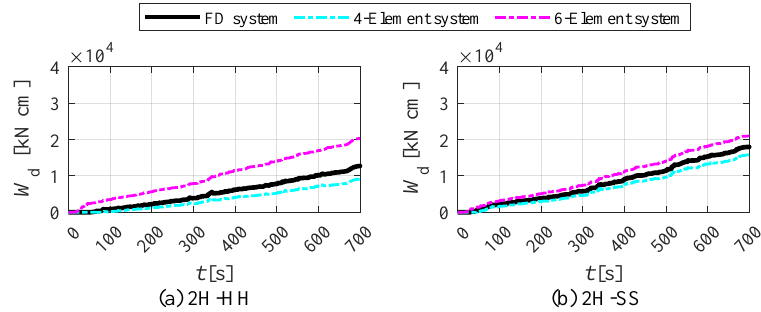
Figure 21. Comparison of the accumulated energy dissipation of the VE dampers (along-wind).